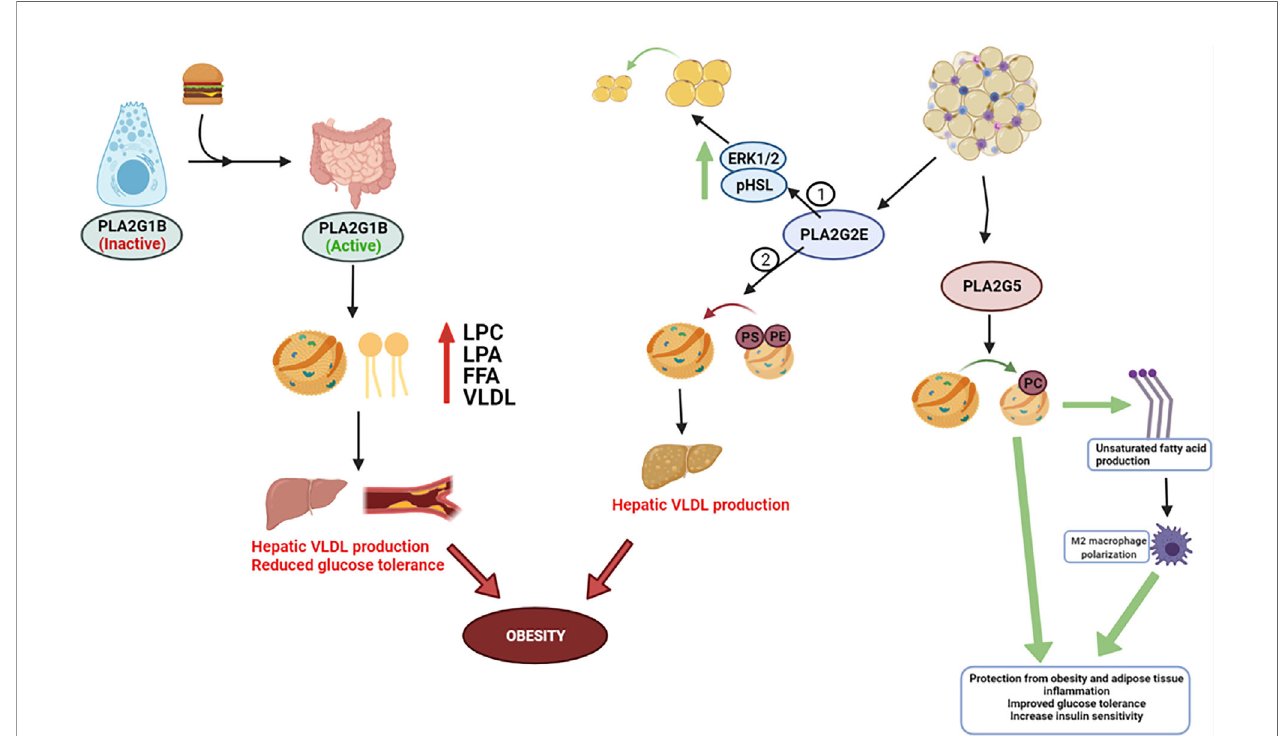
FIGURE 1 | Metabolic role for PLA2s. PLA2G1B is released by pancreatic acinar cells into the pancreatic juice following a meal and then secreted into the intestinal lumen, where it eventually becomes activated. Phospholipid digestion by PLA2G1B results in elevated lysophosphatidylcholine (LPC), lysophosphatidic acid (LPA), and free fatty acids absorption in the portal blood, plasma, and liver, and increases hepatic very-low density lipoprotein (VLDL) production. Elevated enzymatic activity in the intestinal lumen can progress obesity, reduce glucose tolerance, and exacerbate insulin resistance – most notably due to elevated release/absorption of LPC and overarching dyslipidemia. PLA2G2E and PLA2G5 are expressed in WAT. 2 studies have contradicting results in PLA2G2Es metabolic role – 1 study discovered PLA2G2E increases ERK1/2 signaling and HSL phosphorylation to increase lipolysis, whereas Study 2 found PLA2G2E may promote obesity through hepatic lipogenesis and VLDL production. PLA2G5 preferentially hydrolyzes PC-rich phospholipids and promotes M2 macrophage polarization, which appears to have a bene fi cial impact on LDL lipid normalization and whole-body insulin